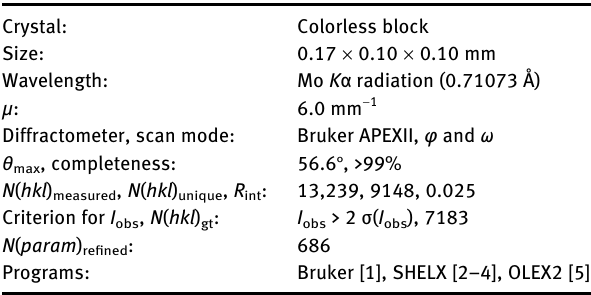
Table  : Data collection and